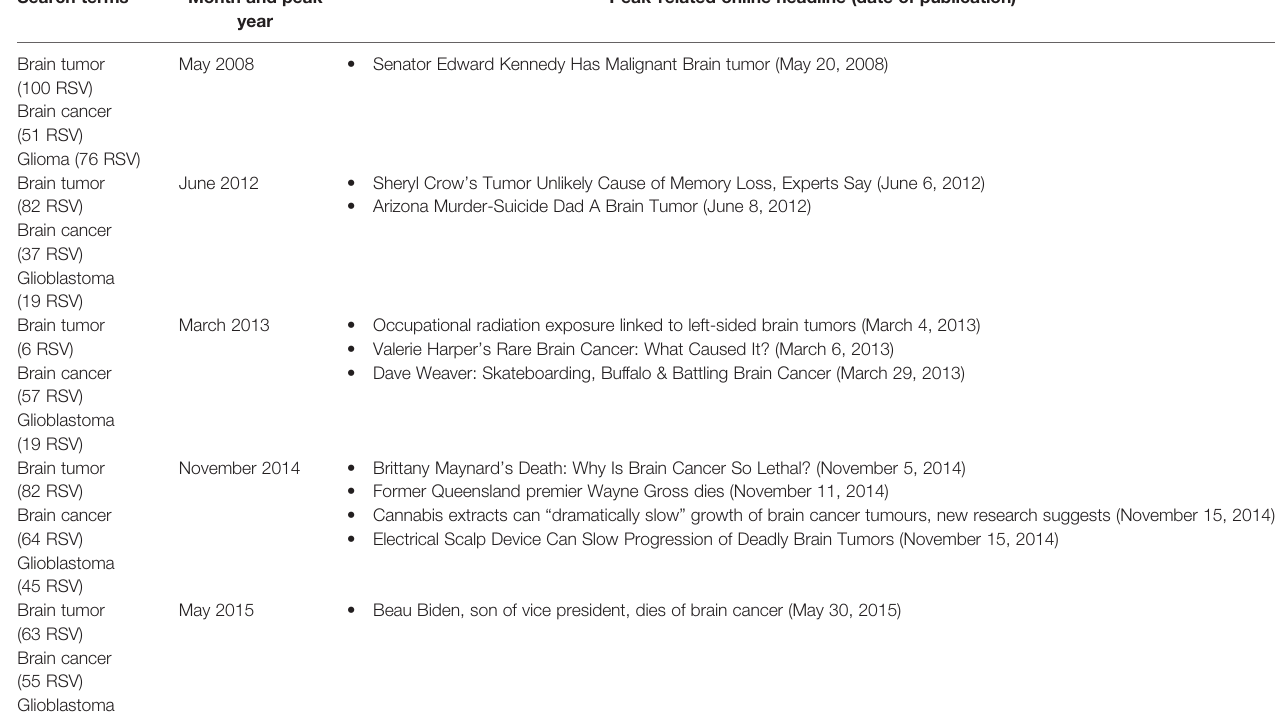
TABLE 3 | Relation of peaks in Google Trends and Wikipedia Pageviews with online news